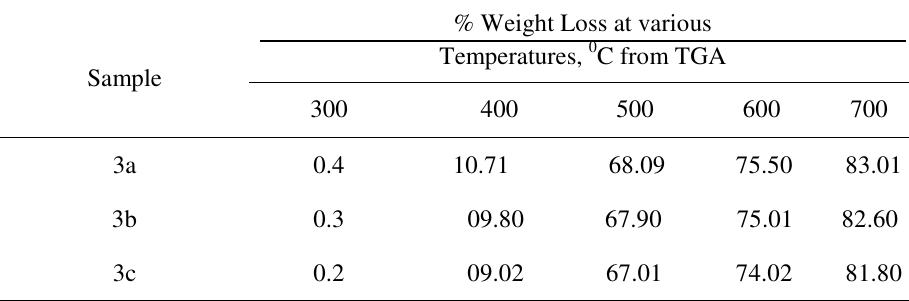
Table 3 . TGA of unreinforced cured samples of epoxy resin % Weight Loss at